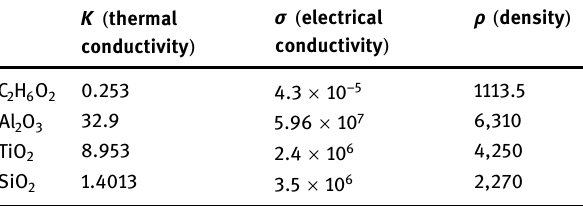
Table 1: Thermal properties of ethylene glycol, silicon dioxide, aluminium oxide, and titanium dioxide - related nanoparticles in EG K ( thermal